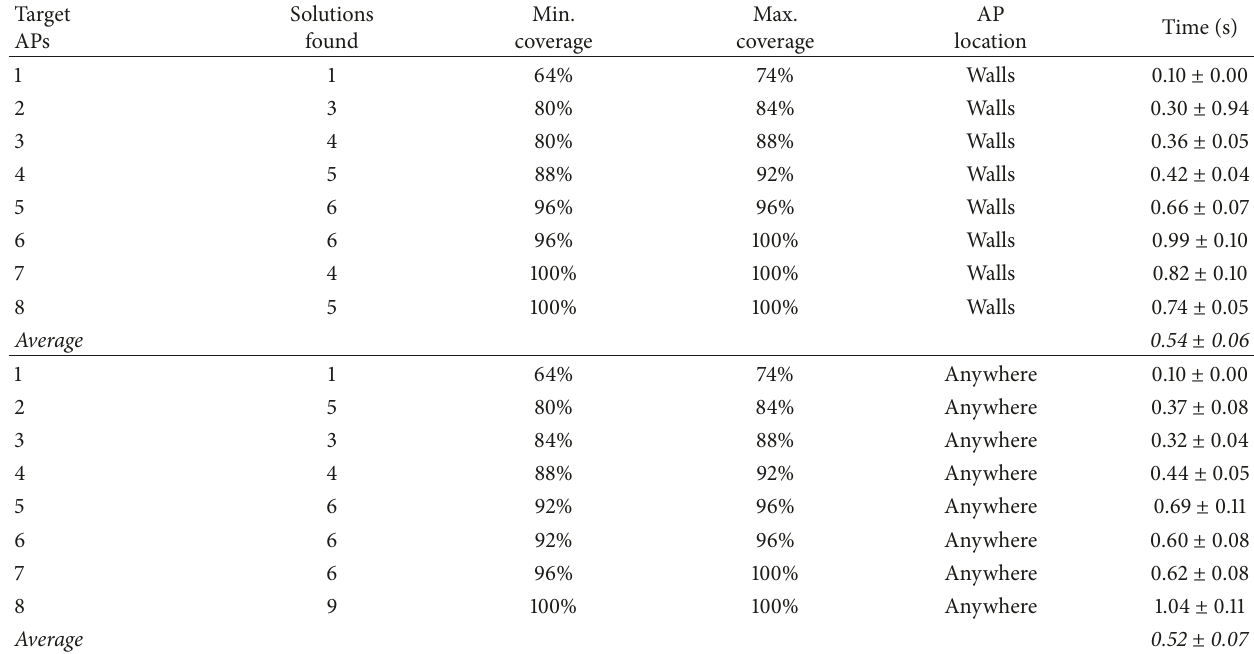
Table 4: Performance of SSGA in a small